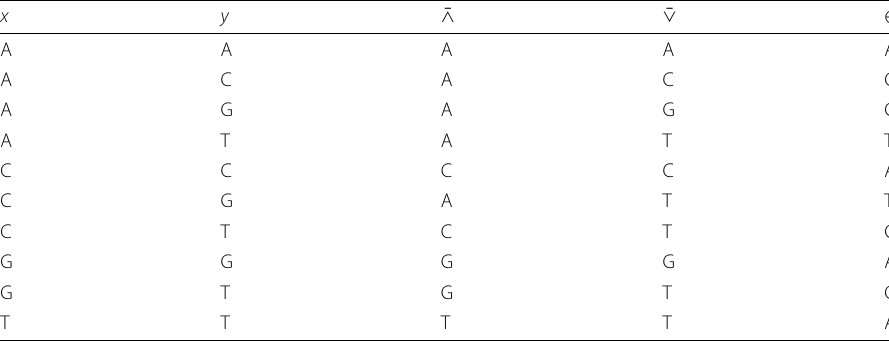
Table 3 Nucleotide operations ¯∧ , ¯∨ , and